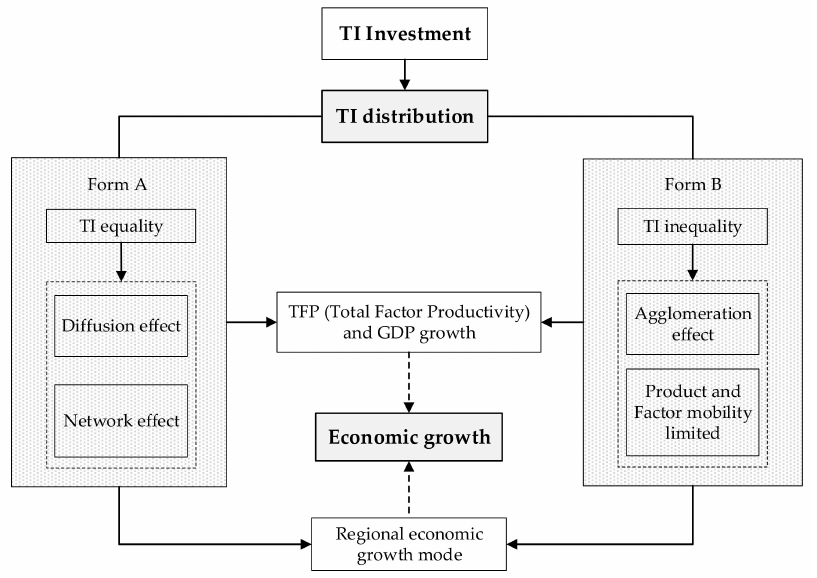
Figure 2. Impacts of TI distribution on economic growth. Note: → direct influence; (cid:57)(cid:57)(cid:75) potential